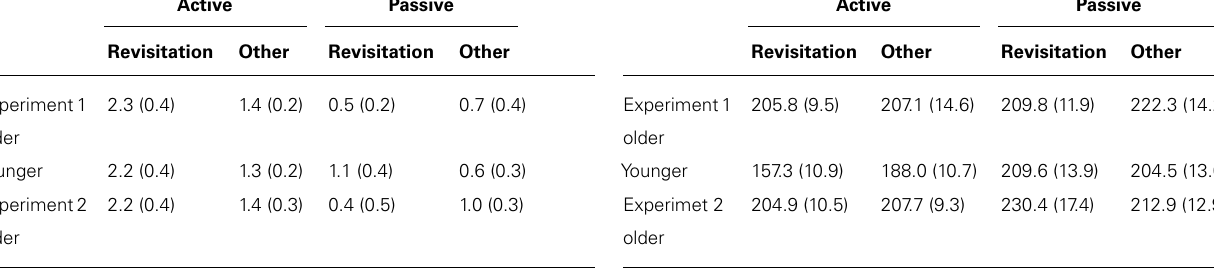
FIGURE 3 | Effects of age on spontaneous revisitation strategy in Experiment 1. (A) The overall proportion of transitions categorized as involving spontaneous revisitation is shown for older and younger adults. (B) The overall proportion of transitions are broken down as a function of the number of objects within each revisitation event (two to six objects) on the right. This shows the distribution of revisitation